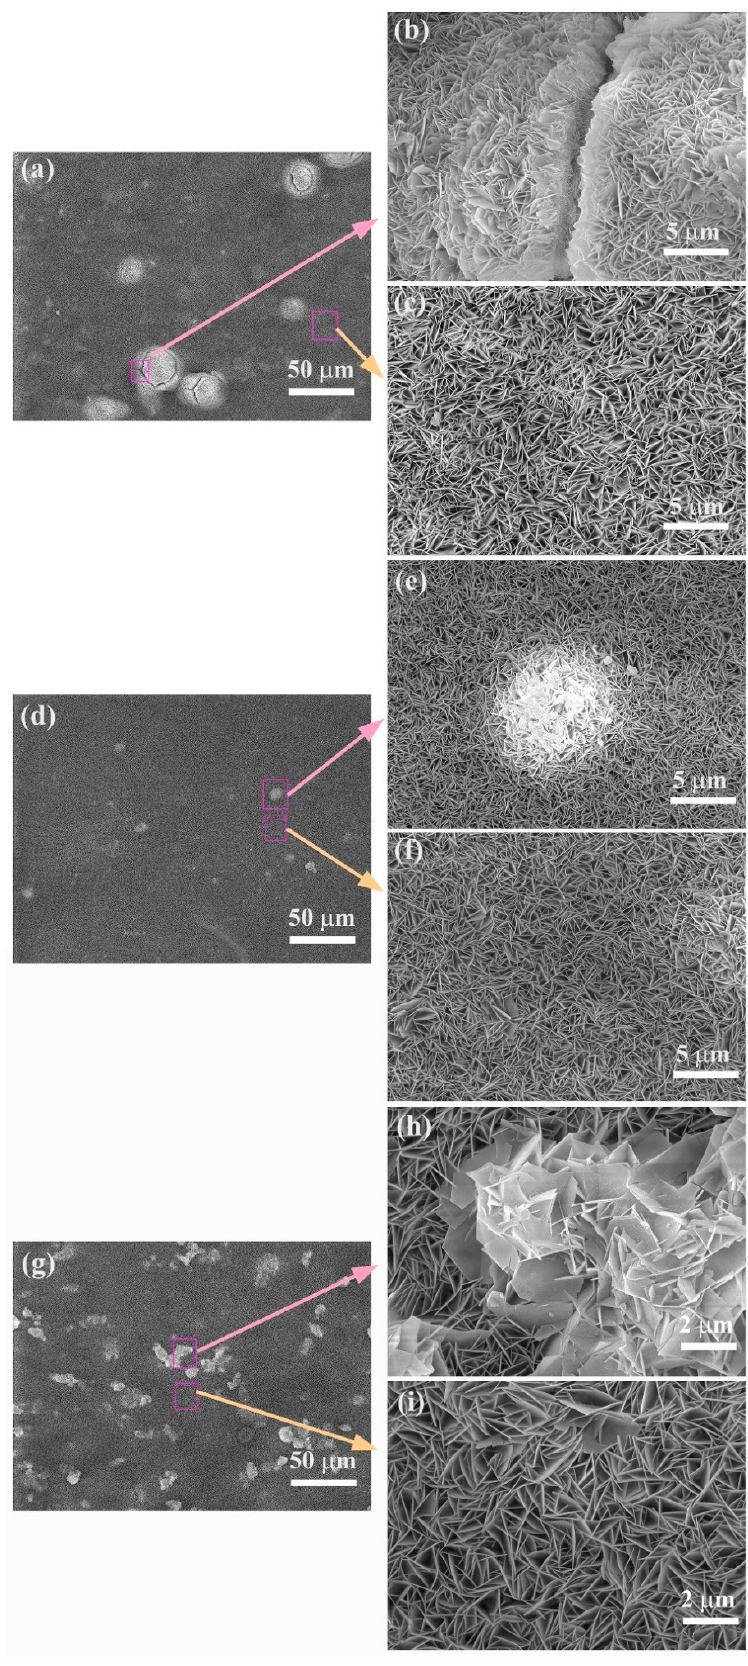
Figure 3. SEM images of the surface morphology of ( a – c ) ZM20-LDHs, ( d – f ) ZM21-LDHs, and ( g – i ) ZM22-LDHs films.